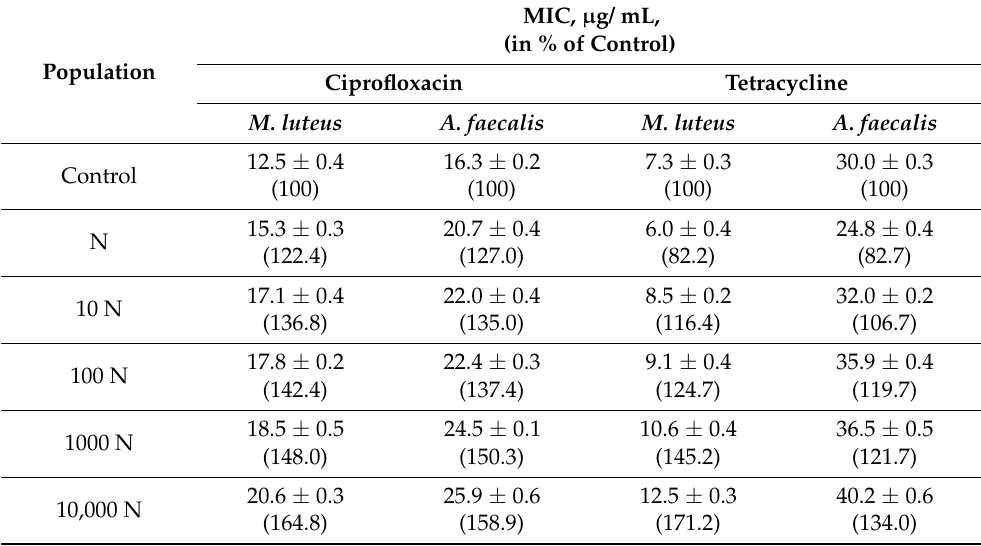
Table 2. MIC values of ciprofloxacin and tetracycline for M. luteus and A. faecalis bacterial cells of control and experimental